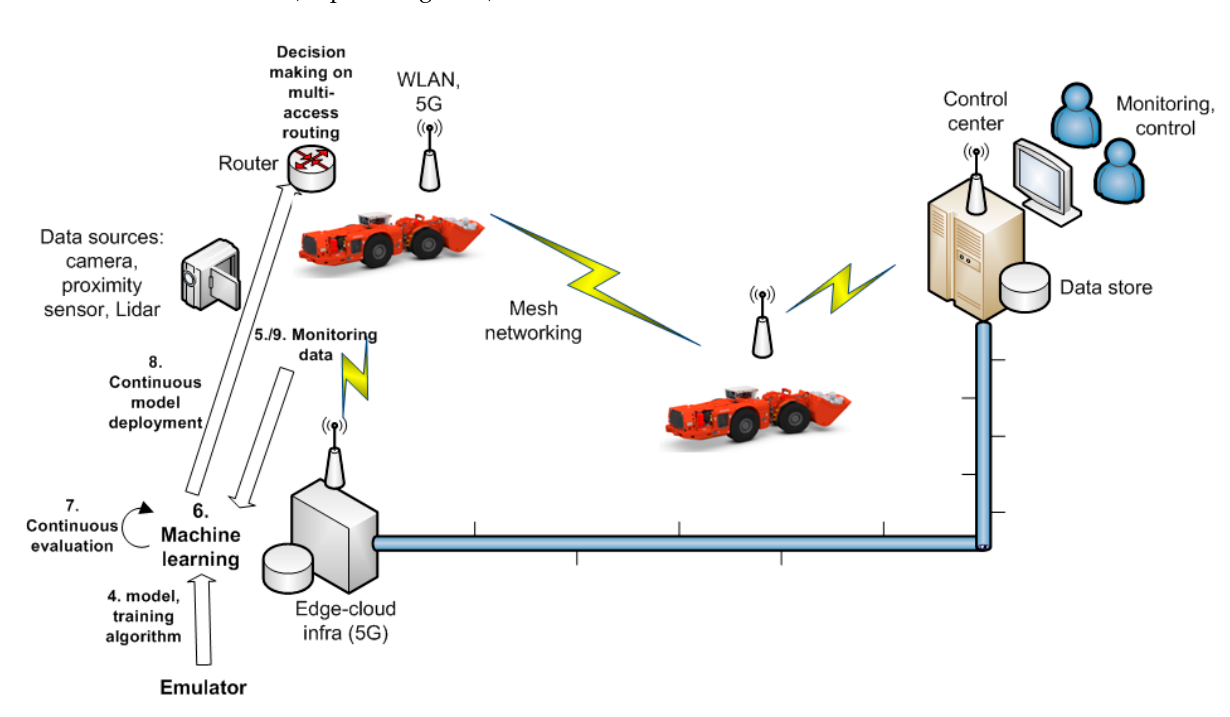
Figure 3. Conceptual view of applying continuous ML in a real mining environment (not imple- mented).